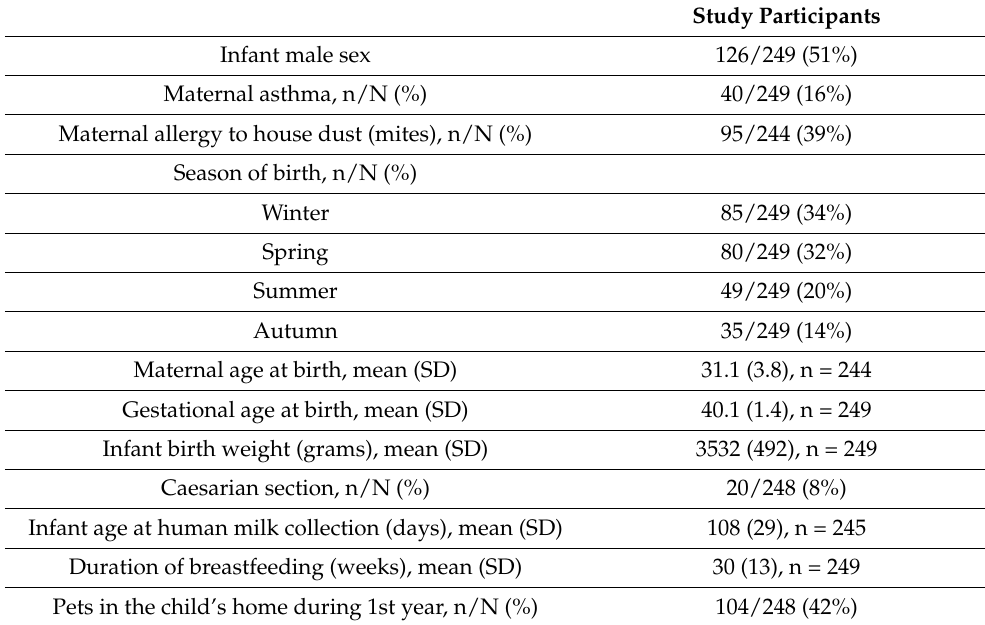
Table 1. Characteristics of the study